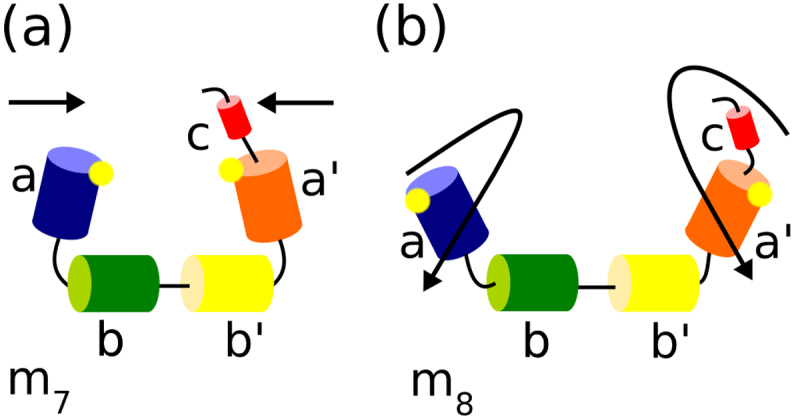
Schematic of low frequency modes of domain motion determined by flexibility analysis.PDI is shown as linked domains, represented as cylinders coloured as in Fig. 1, with active sites indicated as yellow dots. a) Mode 7, m7, the lowest frequency mode of flexible motion (modes 1–6 represent simple translations and rotations) is dominated by the hinge bending (tilting) of the outer domains a and a′ towards and away from each other with the bb′ region relatively fixed. b) Mode 8, m8, the next lowest frequency mode of flexible motion, is dominated by the rotation of domains a and a′ (twisting) relative to bb′. Comparable cartoon representations of modes 9 to 11 for yeast PDI are shown in the supplementary material of Römer et al. [74].